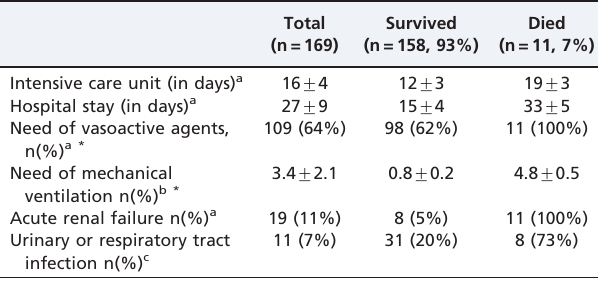
Table 4 - Post-surgical in-hospital data.